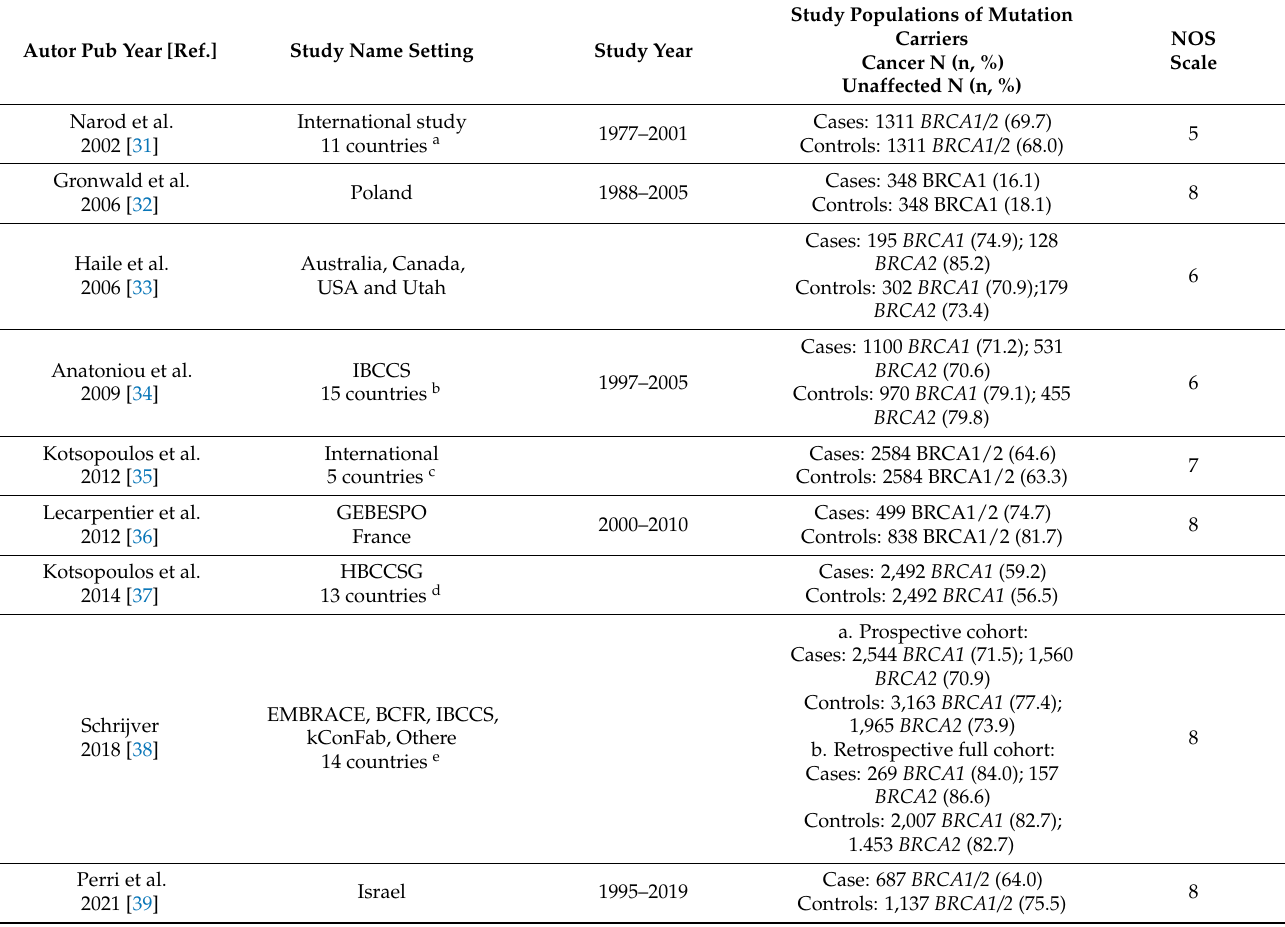
Table 1. Characteristics of case–control studies on the association between breast cancer risk and oral contraception use among BRCA mutation